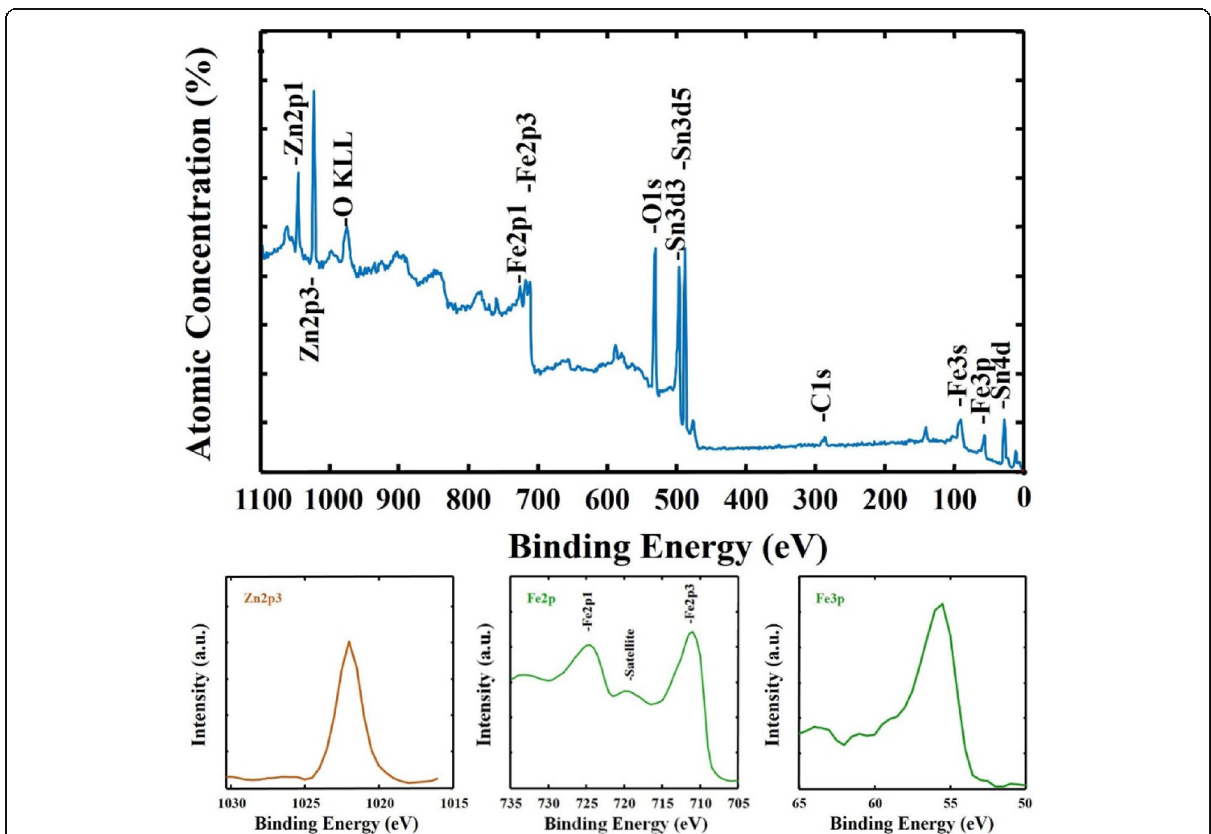
Fig. 3 X-ray photoelectron spectroscopy (XPS) analysis of the Zn/Sn-doped p-n pseudocubic Fe 2 O 3 photoelectrode: a survey XPS spectrum; b Fe 2 p ; and c Zn 2 p